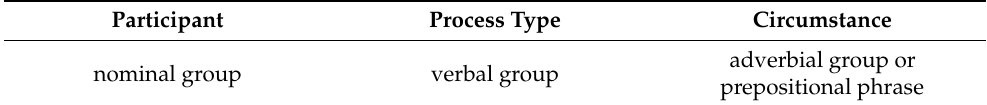
Table 1. Elements in transitivity analysis and their realization.